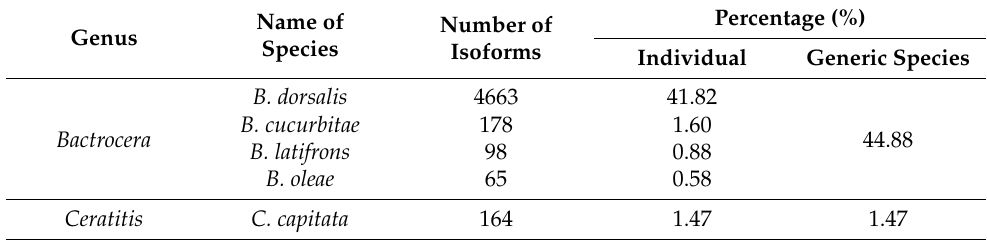
Figure 2. Venn diagram of the number of the annotation results from the four databases. Table 3. The species distribution of the Nr annotation